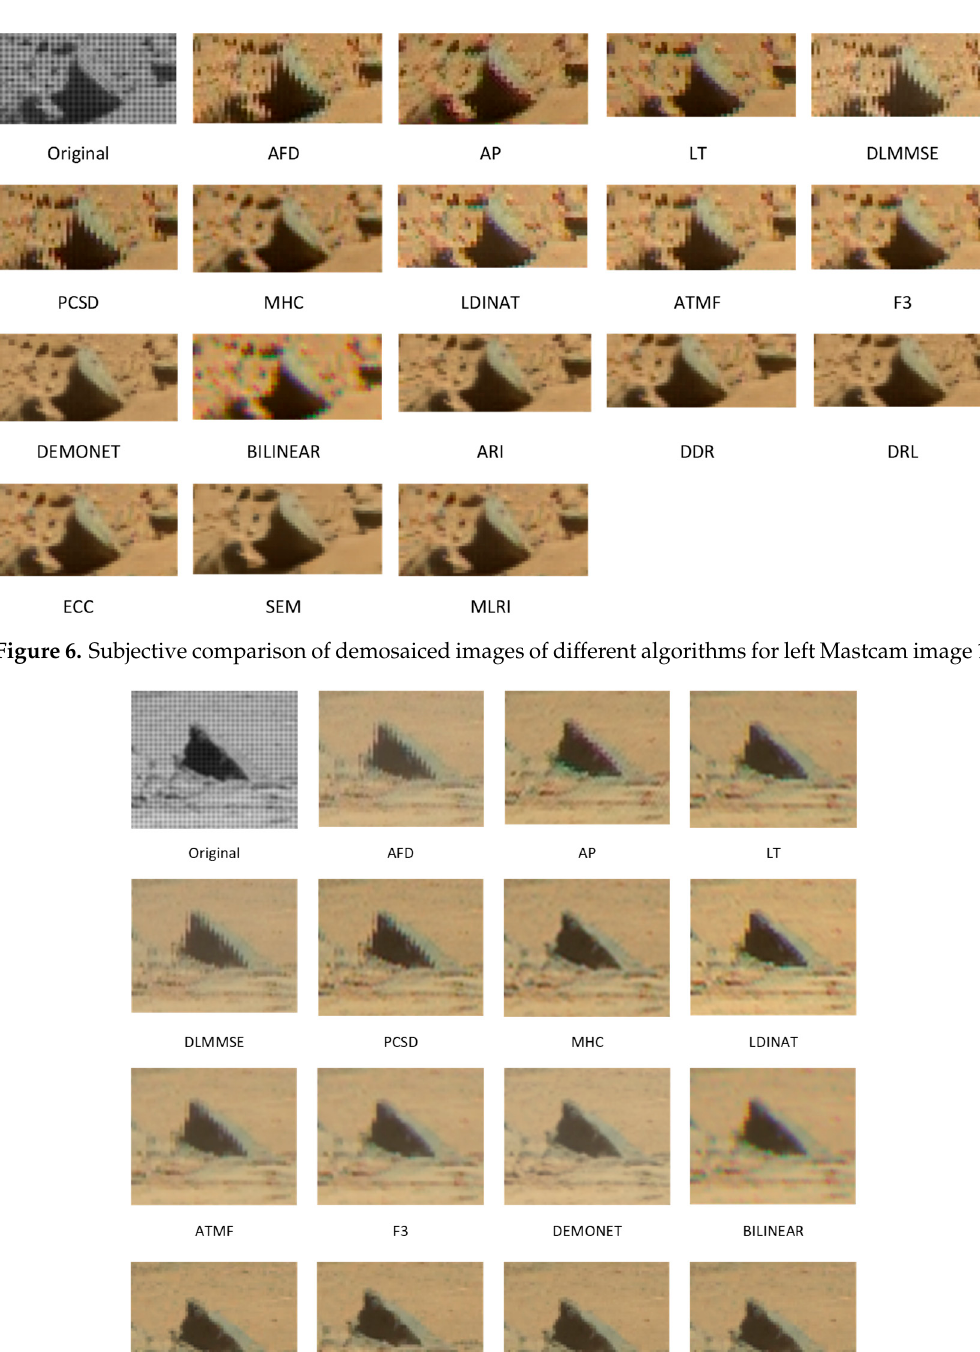
Figure 5. Averaged NIQE scores of R, G, and B bands for left images using all methods.